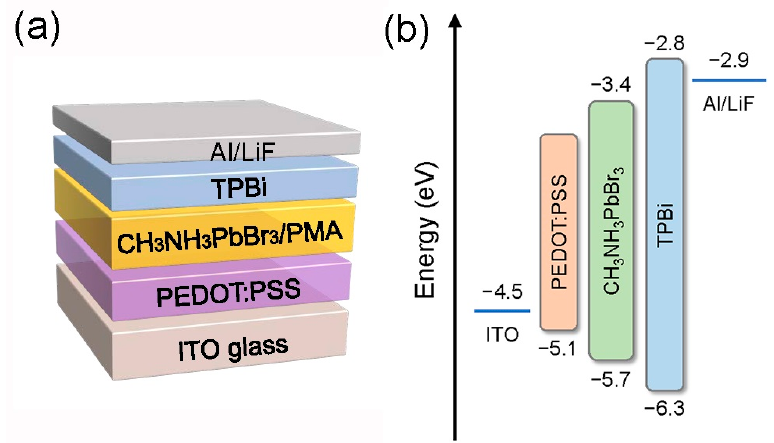
Figure 1. The schematic structure ( a ) and energy level diagram ( b ) of the PeLEDs.